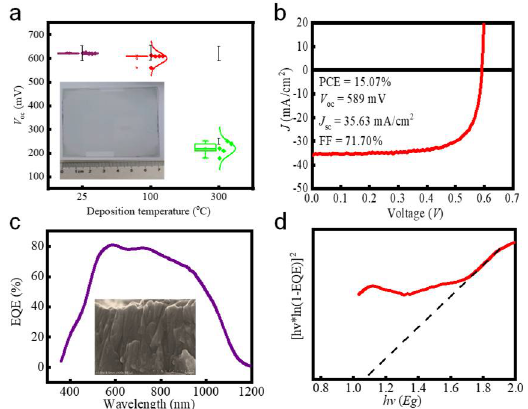
Figure 2. ( a ) The statistical distribution of V oc for CIGS solar cells with AZO films as TCOs deposited at different temperatures. The inset shows the photo image of AZO films grown on the soda − lime glass with an area of 100 cm 2 . ( b ) J − V curve of the CIGS solar cell with the highest PCE of 15.07% free of antireflection layer and alkali metal treatment. ( c ) Typical EQE curve for the CIGS solar cell with an efficiency of 15.07%. The inset shows the column morphology of AZO. ( d ) Band gap of CIGS obtained from the curve of [ hv × ln(1−EQE)] 2 vs. hv .